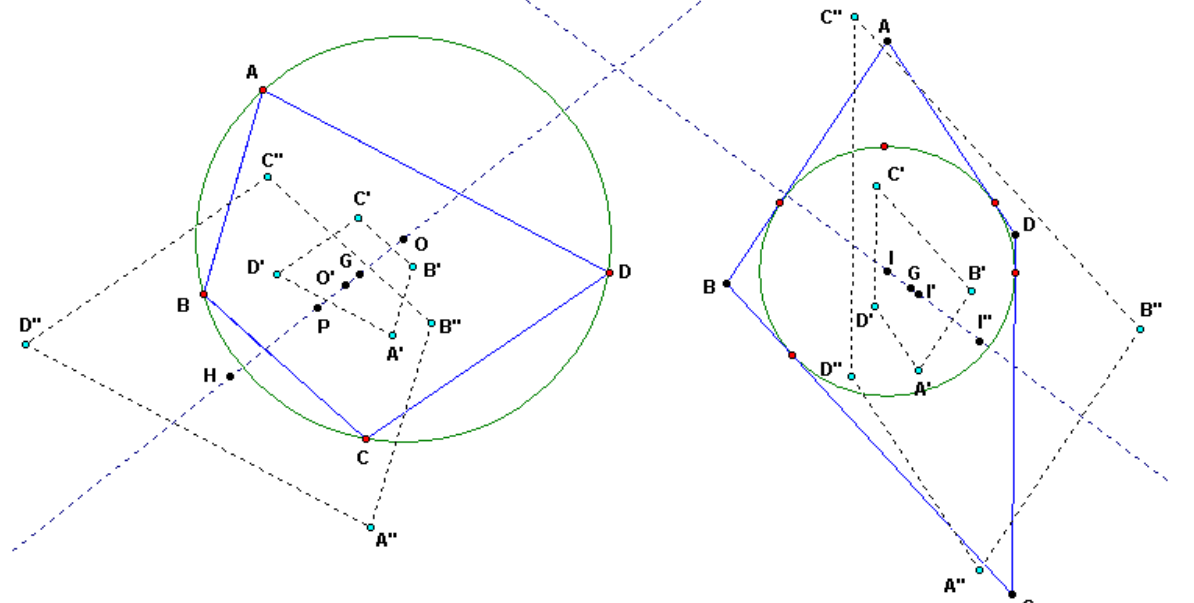
Figure 7: Euler line of cyclic quad and Nagel line of circum